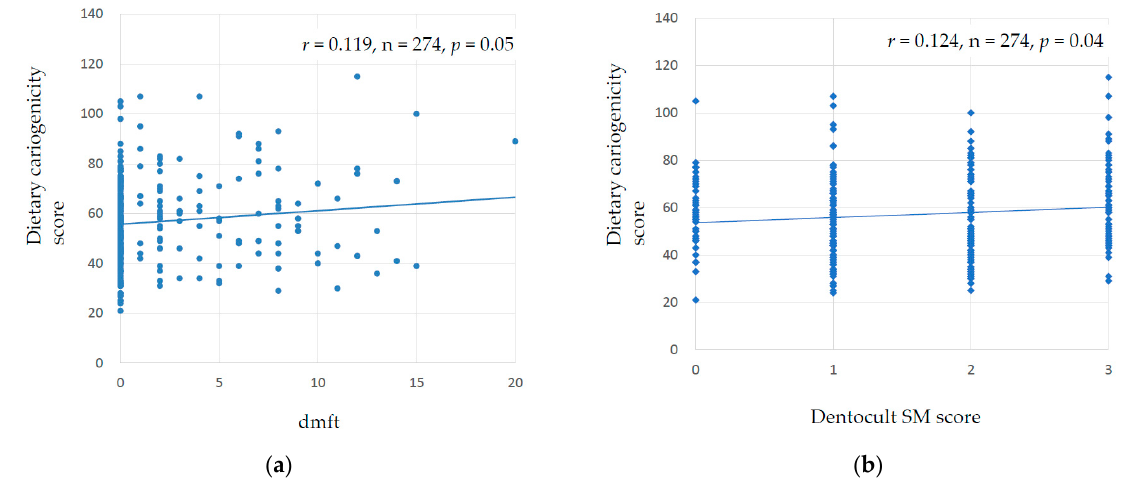
Figure 1. Scatter plots of the relationship between ( a ) dietary cariogenicity score and dmft index, and ( b ) dietary cariogenicity and Dentocult SM scores. Table 4. Mean dietary cariogenicity scores for each Dentocult SM score category ( n = 274).